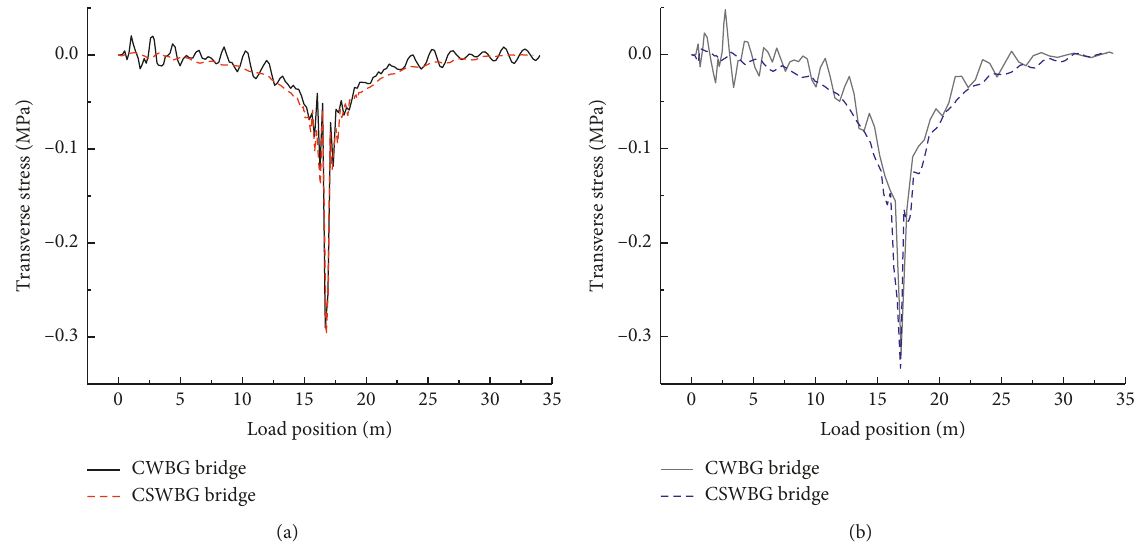
Figure 9: Comparison of transverse stress on the surface of the bridge deck pavement of both models. (a) Single wheel load. (b) Dual wheel load.